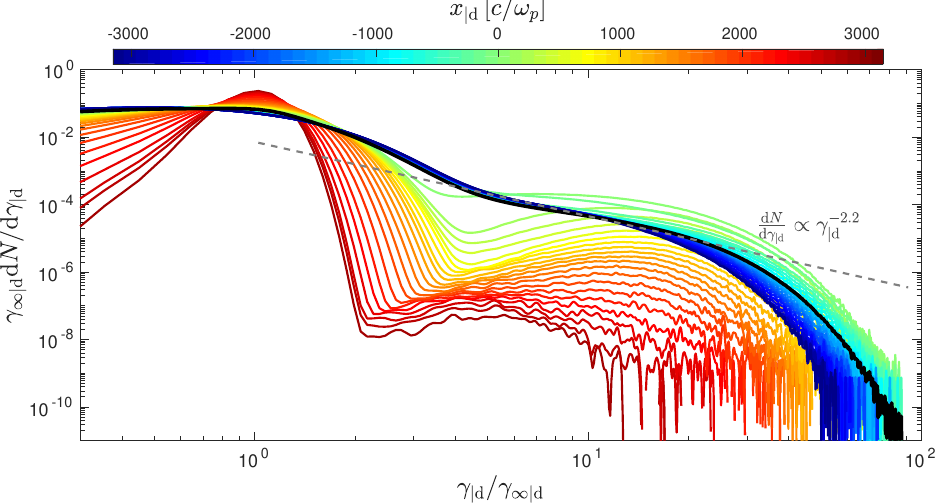
Figure 8. Particle energy spectrum taken from a PIC simulation of a relativistic pair shock with γ sh = 173 and σ = 0, at different distances x | d from the shock front, as indicated by the color scale. Positive (resp. negative) values of x | d correspond to upstream (resp. downstream). The black line shows the spectrum integrated over the whole simulation box and is compared by the theoretical prediction of a powerlaw with s = 2.2. From